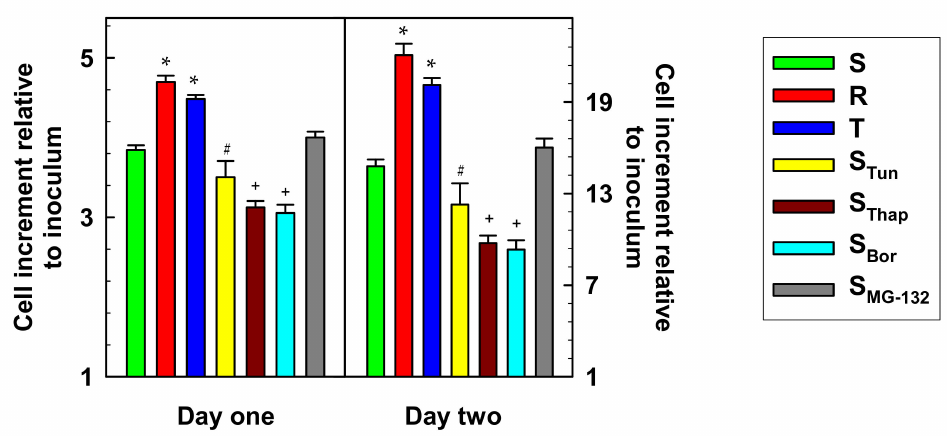
Figure 2. Cell growth after the first and second days of culture. All cell variants were cultured under standard conditions (see the Section 4). Data were calculated by nonlinear regression with Equation (2) according to the growth lines documented in Figure S1 (Supplementary files). Data represent the calculated value ± S D for 28 degrees of freedom. Significance: * significantly higher than the value obtained for S cells at p < 0.02; # and + significantly lower than the value obtained for S cells at p < 0.05 and p < 0.02,